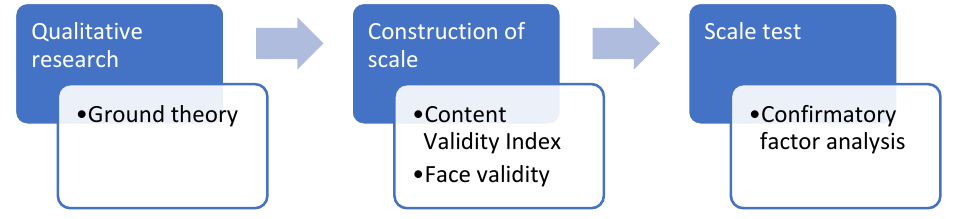
Figure 1. Flowchart of qualitative research.